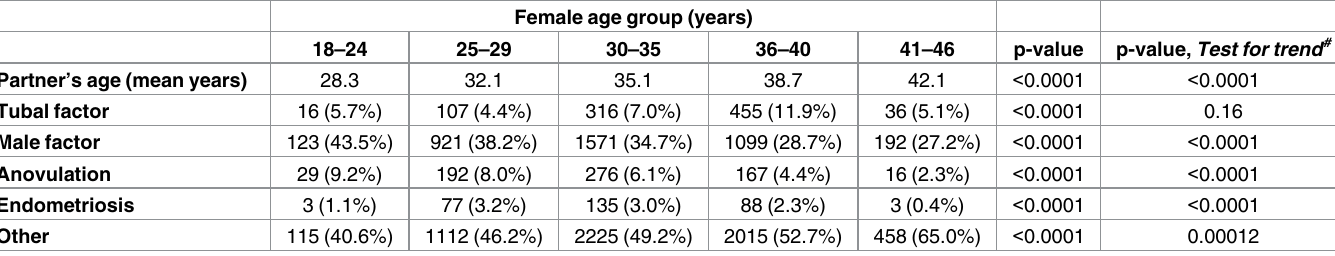
Table 1. Partner’s age and referral diagnosis in relation to the age of the women undergoing IVF or